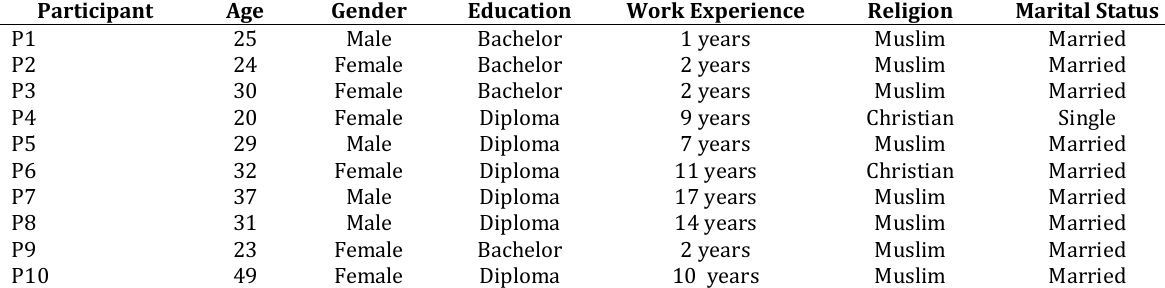
Table 1. List and Characteristics of Participants Participant